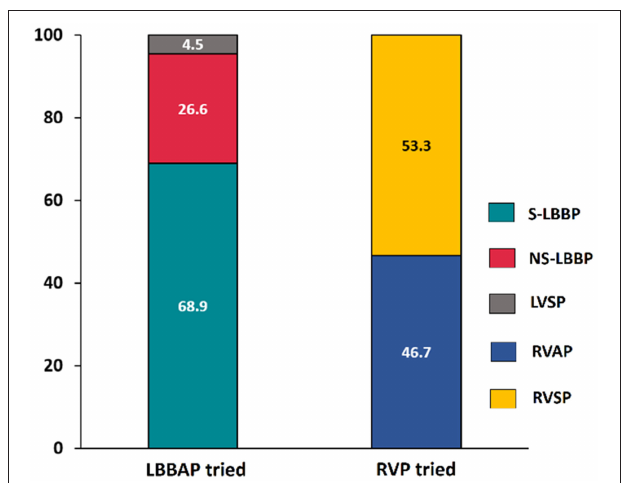
FIGURE 2 | Comparison of success rate between LBBAP and RVP. LBBAP, left bundle branch area pacing; S-LBBP, selective left bundle branch pacing; NS-LBBP, non-selective left bundle branch pacing; LVSP, left ventricular septal pacing; RVAP, right ventricular apical pacing; RVSP, right ventricular septal